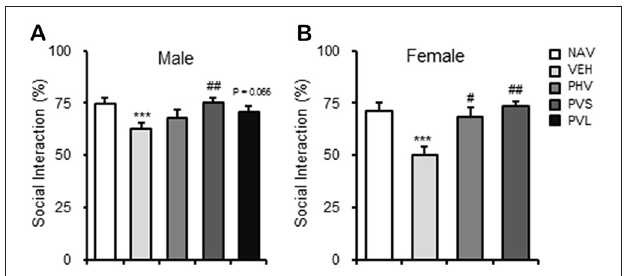
FIGURE 5 | HRW administration reversed the memory impairment in VPA-exposed male mice offspring. HRW administration significantly reversed the maternal VPA exposure-induced the memory impairment of male (A) mice offspring and significantly enhanced that of female (B) mice offspring in the contextual fear memory test. ∗ P < 0.05 compared with the saline-injected group (NAV; n = 6–10 per